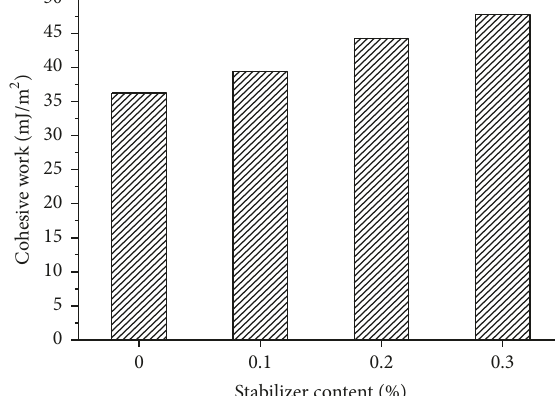
Figure 10: The cohesive work versus stabilizer content of SBS- modified